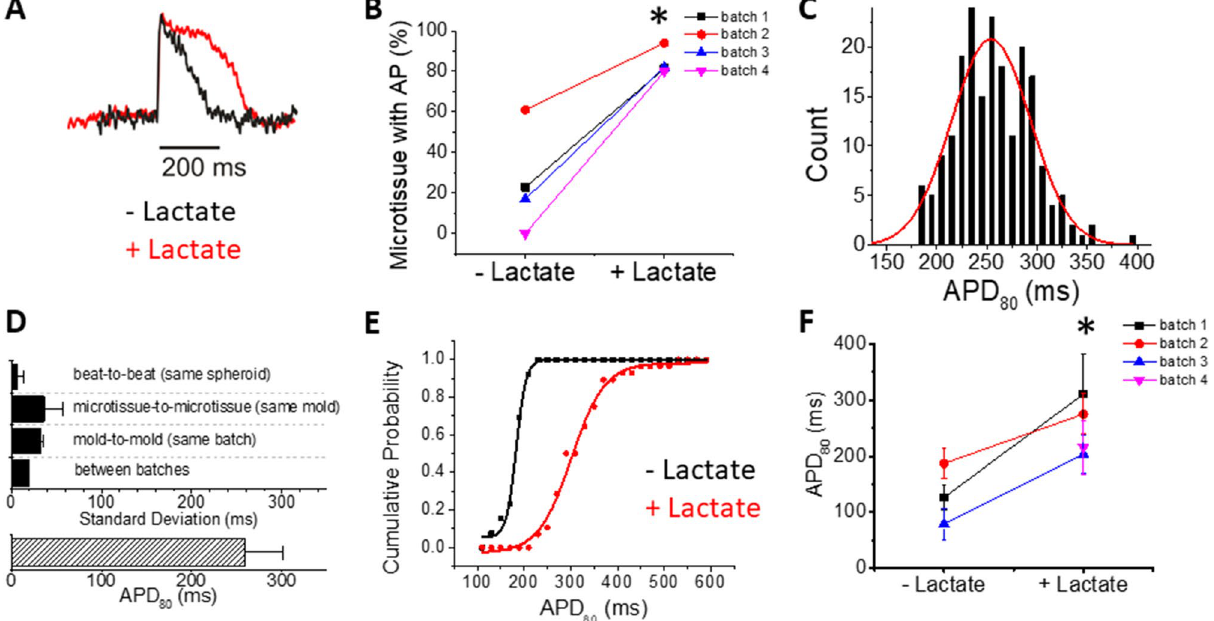
Figure 3. Lactate purification of hiPSC-CMs prior to microtissue formation with 5% hCFs improves excitability and lengthens APD. ( A ) Representative V m traces from microtissues formed from hiPSC-CMs with (red) and without lactate purification (black) plus 5% hCFs. HiPSC-CMs from the same differentiation batch but grown in 2D culture without the lactate selection protocol for 28 days (to match the age of the cells) were used as the most appropriate control for comparison. ( B ) Percent of hiPSC-CM microtissues showing APs during 0.5 Hz pacing increases with lactate purification of hiPSC-CMs (n = 4 batches, minimum 2 molds per batch). ( C ) APD 80 distribution from 35 microtissues in a single mold with hiPSC-CM LP and 5% hCF. ( D ) The average APD 80 was 259.0 ± 42.0 ms (n = 201). APD 80 variation between batches is small with hiPSC-CM LP : APDs were measured at 0.5 Hz cycle length pacing. The standard deviation from beat-to-beat in the same microtissue (technical replicates) was 6.4 ± 6.5 ms (n > 35 microtissues per batch, n = 4 batches), from microtissue-to- microtissue in the same mold (biological replicates) was 36.1 ± 21.4 ms (n = 2–3 molds per batch, n = 4 batches), from mold-to-mold in the same batch (also biological variability) was 31.8 ± 3.8 ms (n = 2–3 molds per batch, n = 4 batches), and from batch-to-batch, the standard deviation (another level of biological variability) was 19.3 ms (n = 4 batches). ( E ) Cumulative probability plot for APD 80 (n = 3–4 batches, at least 2 molds per batch) shows consistently longer APD 80 with hiPSC-CM LP (red) vs. hiPSC-CM (black). ( F ) Comparison of APDs from microtissues from the same experimental batch (each color) with and without lactate purification (n = 4 batches, ≥ 2 molds per batch). Values are means ± SD. * P < 0.05). Note that in batch 4, the microtissues generated from hiPSC-CM without lactate purification were not batches), the mean APD 80 was 160.0 ± 33.1 ms (Fig. 2C, bottom). The standard deviation from batch to batch (“between batches”) was the largest of our biological variability metrics at > 30 ms. Microtissue-to-microtissue and mold-to-mold variability were smaller, and variability in technical replicates beat-to-beat (same microtissue) was < 10 ms (Fig. 2C). Action potential duration showed the expected physiological rate dependence at physi-